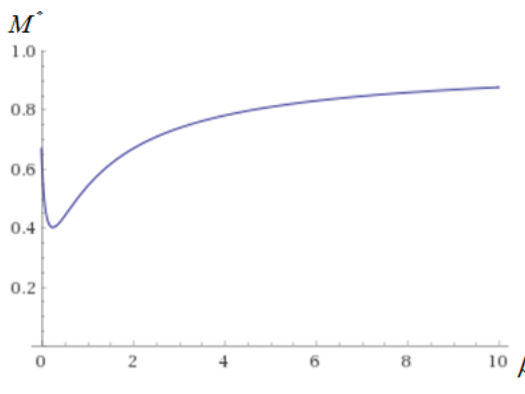
Figure 3. Relationship between 𝑀 ∗ and 𝛽 .